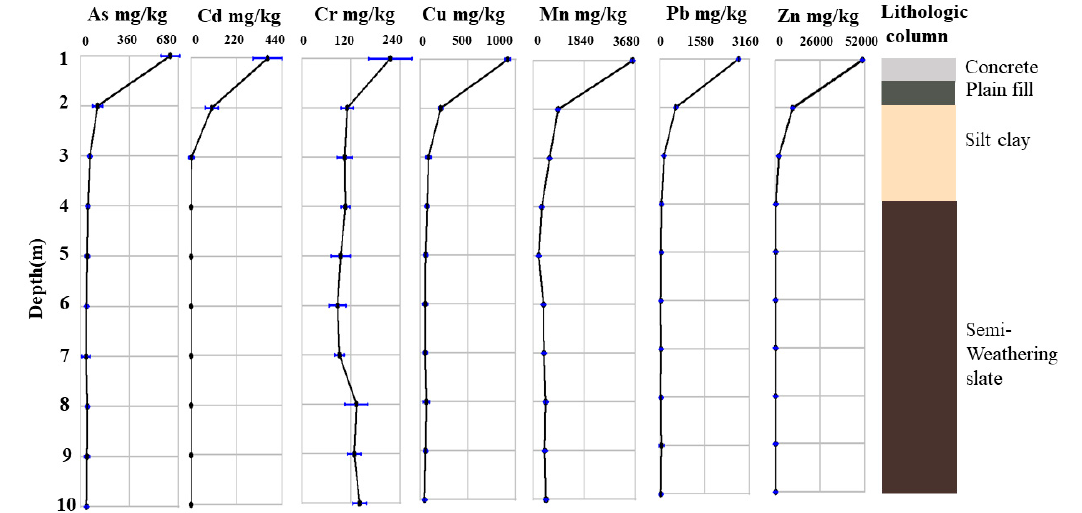
Figure 2. The mean concentration of As, Cd, Cr, Cu, Mn, Pb and Zn in soil vertical profile.